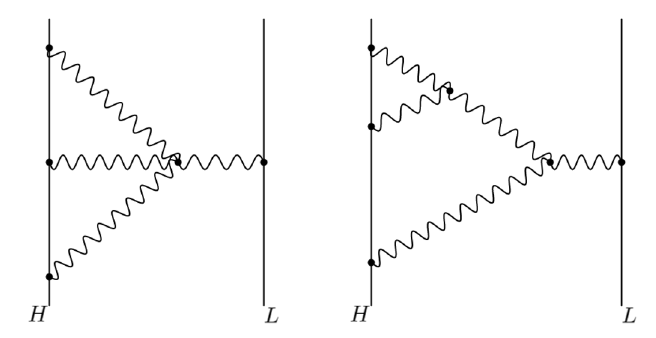
/c 2 , respectively. H